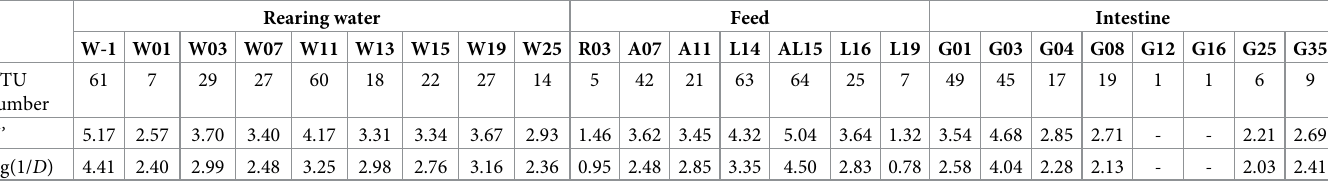
Table 2. Diversity indices of bacterial communities in